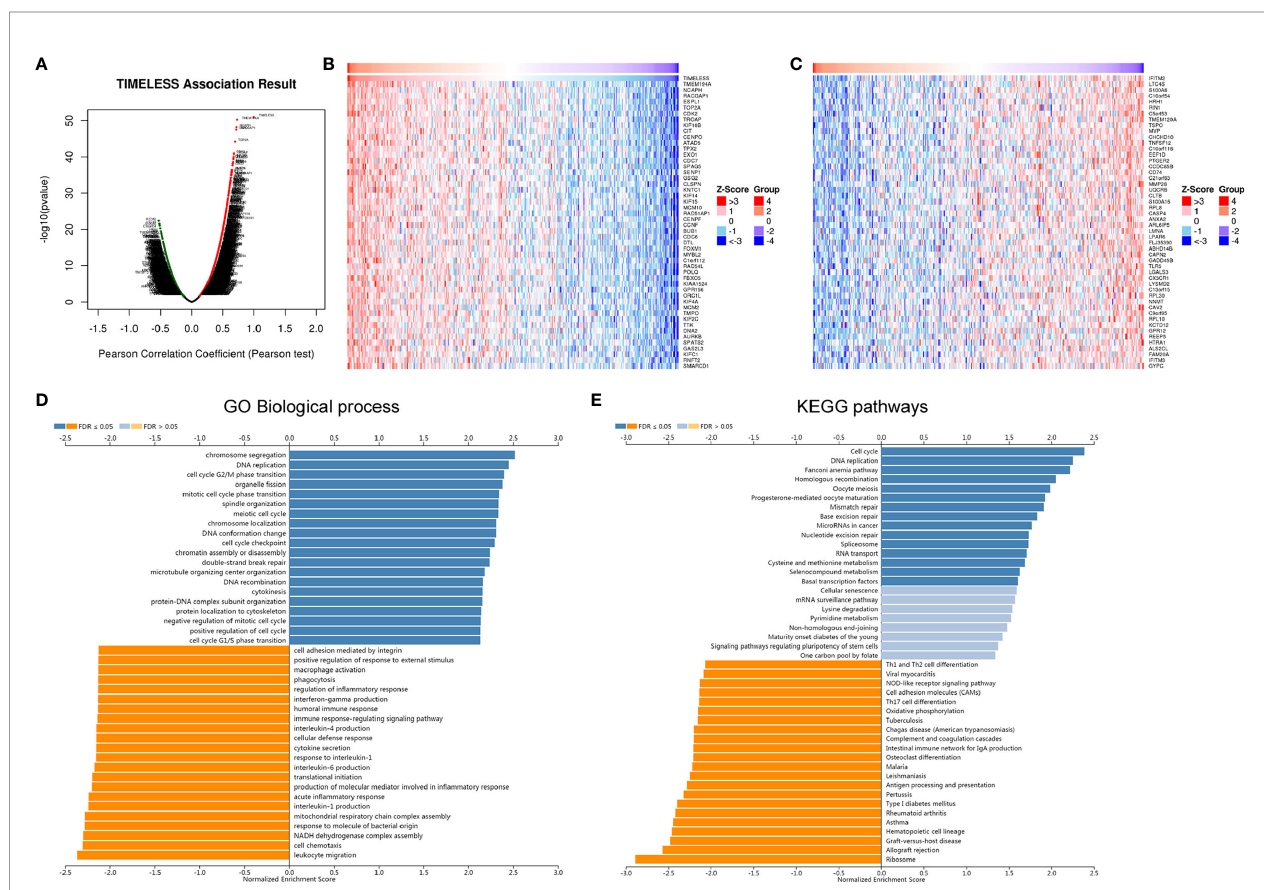
FIGURE 4 | The co-expression genes with TIM in OV using online LinkedOmics database. (A) All signi fi cantly associated genes with TIM in TCGA-OV cohort were shown. Red represents positively linked genes, green represents negatively linked genes, and black indicates no correlated genes with TIMELESS. (B) Top 50 genes positively related to TIM in OV were shown in heatmap. Red represents positively linked genes, and blue represents negatively linked genes. (C) Top 50 genes negatively related to TIM in OV were shown in heatmap. (D, E) GO Biological process annotations and KEGG pathways of TIM in TCGA-OV cohort were